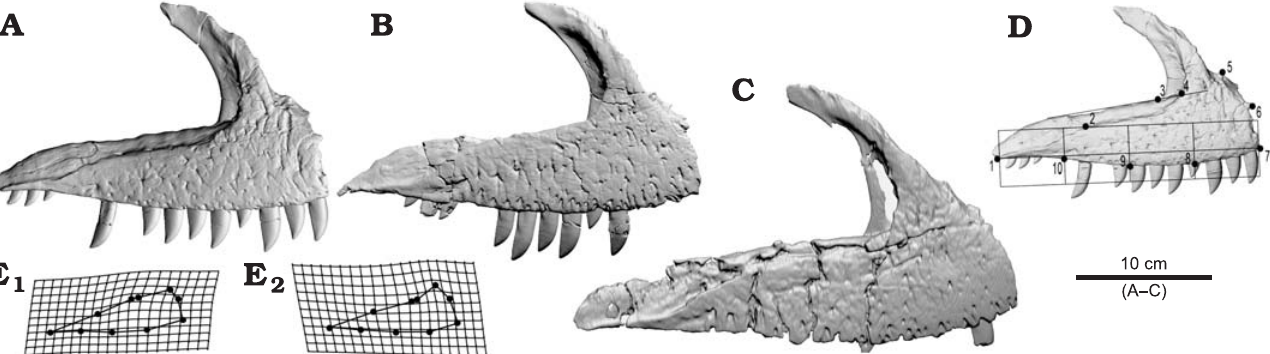
Fig. 4. Representative maxillae (rendered CT images) of Majungasaurus crenatissimus (Depéret, 1896) Lavocat, 1955 from the Maastrichtian (Upper Cretaceous) Maevarano Formation, northwestern Madagascar in right lateral view. A . UA 9944. B . FMNH PR. 3369. C . FMNH PR 2278. D . Illustration of landmark positions used for maxillae. Black circles, landmarks. E . Ontogenetic shape change visualized by deformation grids relative to average; out- line of smallest (E 1 ) and largest (E 2 ) specimens from average.